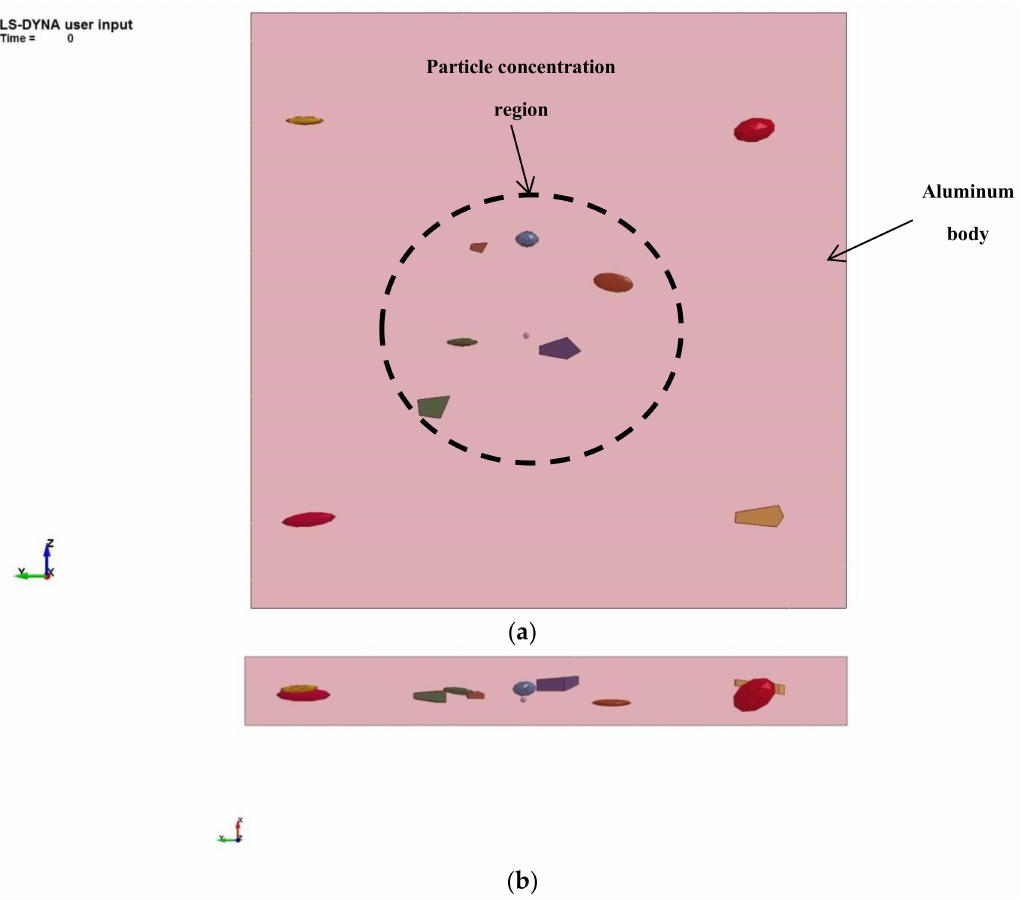
Figure 1. Particles distribution in aluminum body for FEA: ( a ) Top view and ( b ) side view imaging.